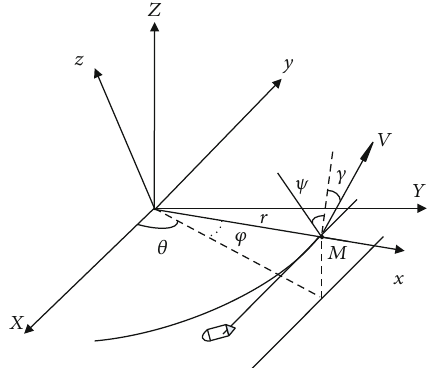
Figure 5: Parameters of three-dimensional dynamics in the Earth ’ s